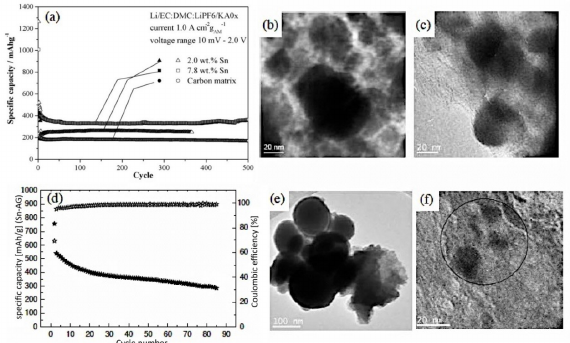
Figure 2: Volume fraction and size effects on capacity: (a) Capacity increase upon volume fraction increase of Sn content; (b) Corre- sponding Sn particles of size 20-50 nm before electrochemical cycling; (c) Mechanical stability of these particles after 80 cycles; (d) Capacity fade of larger Sn particles 100 nm as shown in (e), as shown in (f). (Courtesy of K.E. Aifantis; see also K.E. Aifantis